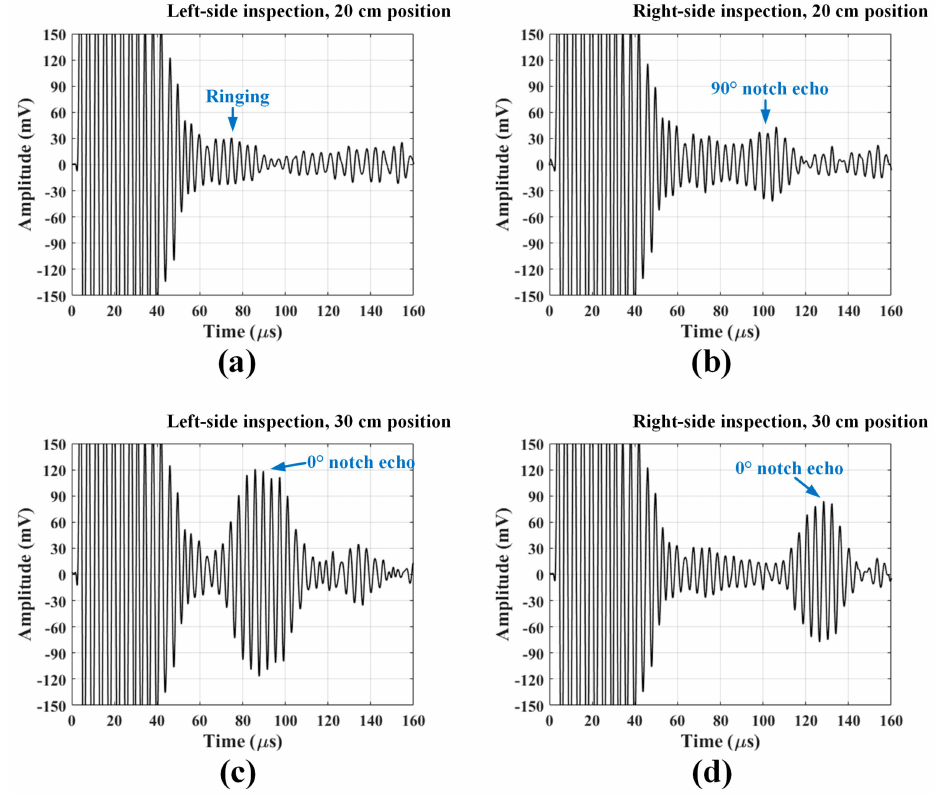
Figure 15. The waveform signals taken when the EMAT pair is located at ( a , b ) 20 cm position; and ( c , d ) 30 cm